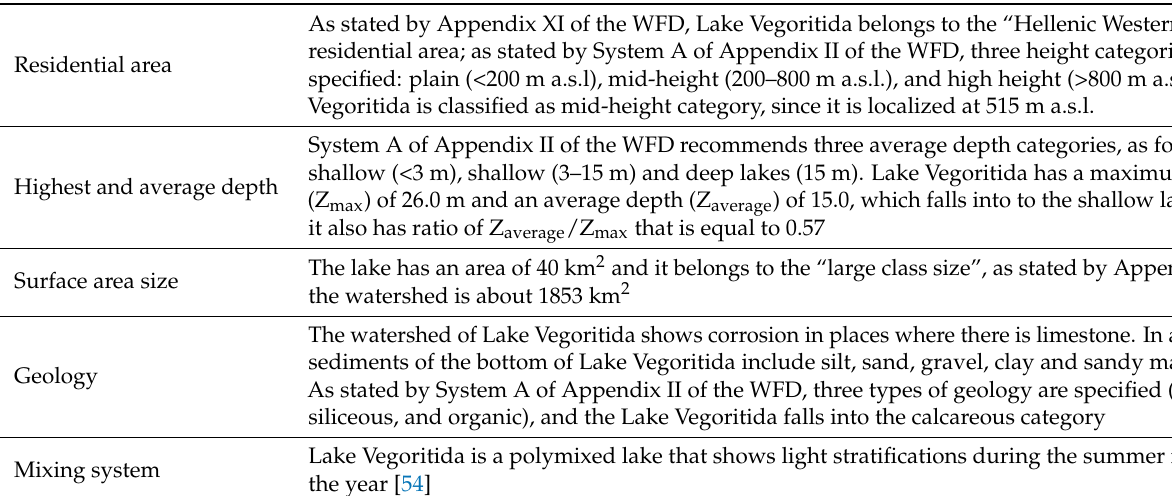
Table 4. Classification of Lake Vegoritida based on the WFD ECOFRAME scheme and comparative literature—MED-GIG system